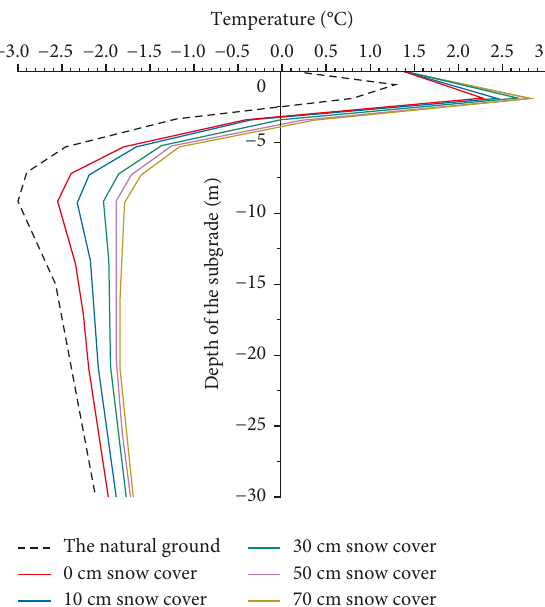
Figure 9: The temperature on October 1 of the roadbed after 30years operation.